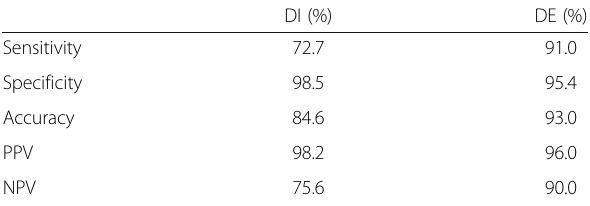
Table 1 Serological intrinsic parameters of double immunodiffusion test (DI) and Dot-ELISA technique